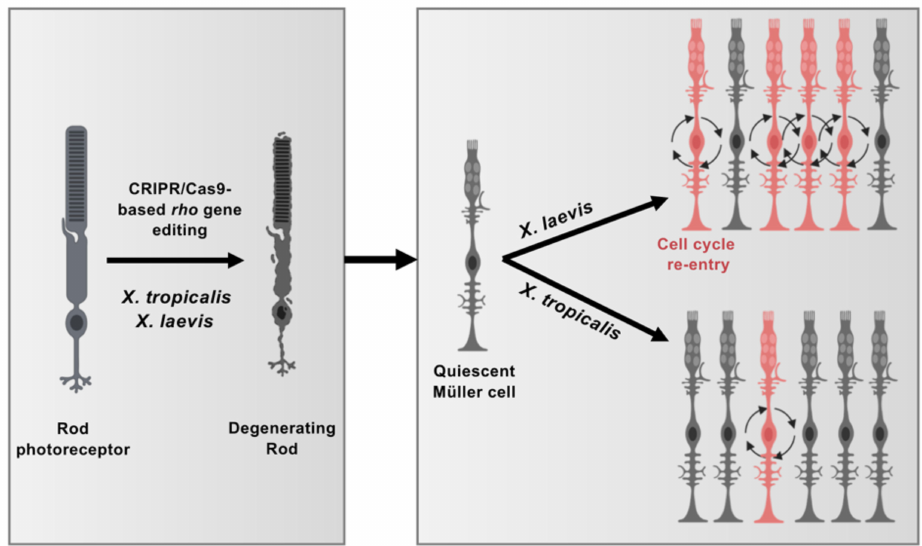
Figure 8. Model illustrating differences in Müller cell response to injury in X. tropicalis and X. laevis . CRISPR/Cas9-mediated rho editing triggers rod photoreceptor degeneration in both X. tropicalis and X. laevis . Quiescent Müller cells respond to this pathological context by re-entering into cell cycle. While Müller cell proliferation is greatly enhanced in X. laevis , it remains limited in X. tropicalis , suggesting divergent regenerative properties of these closely related species. This figure was created with schemas from ©BioRender—biorender.com accessed on November